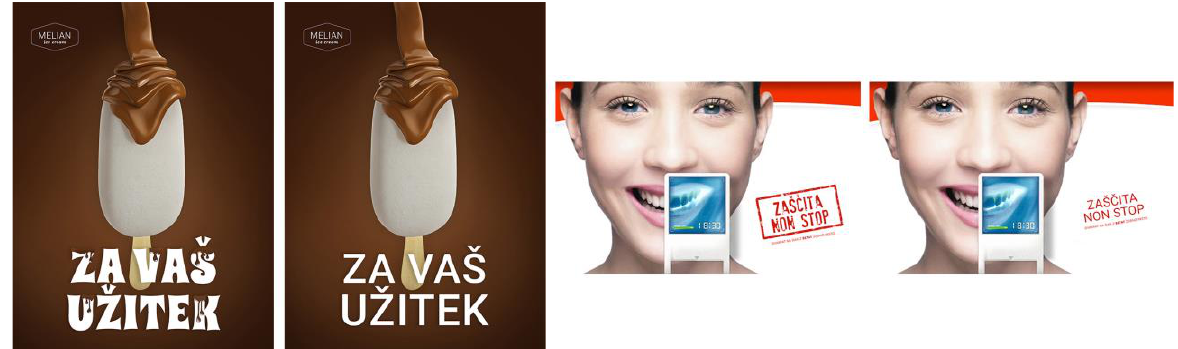
Figure 4. Example stimuli. Ice cream ad copy “For your pleasure”; toothpaste ad copy “Non-stop